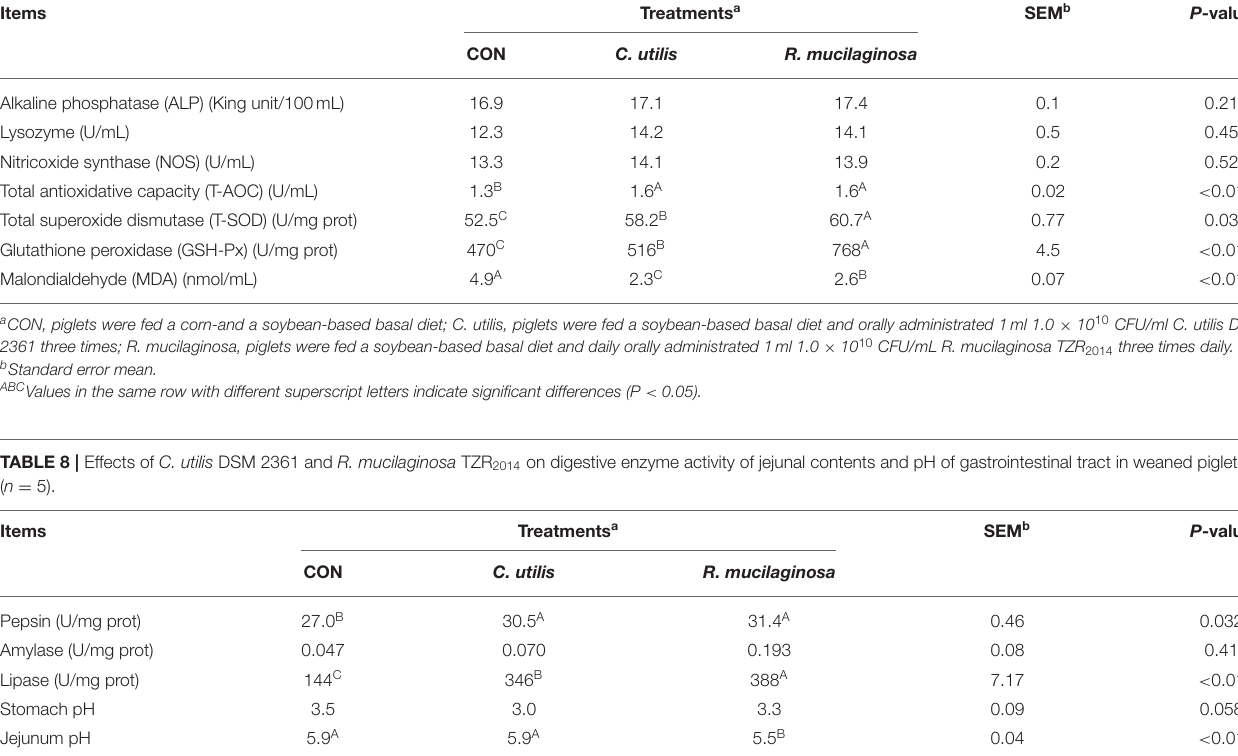
TABLE 7 | Effects of C. utilis DSM 2361 and R. mucilaginosa TZR 2014 on serum blood biochemical indicators in weaned piglets ( n = 5). Items Treatments a SEM b P -value CON C. utilis